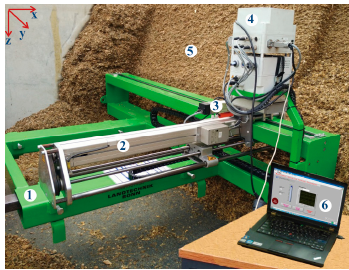
Figure 1. A photo of the penetrometer-based mapping system: (1) frame, (2) penetrometer, (3) motor for y-axis translation, (4) relay-box, (5) maize silo, and (6) the interface of the measurement system.